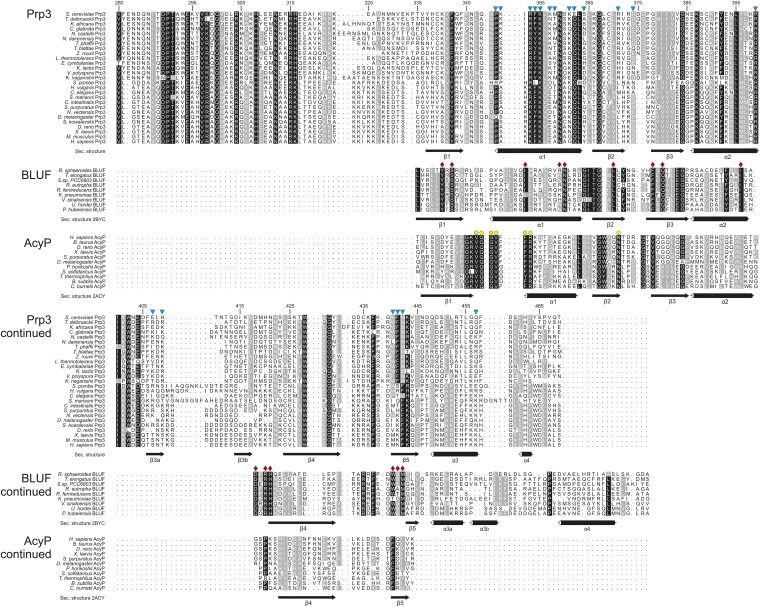
Protein sequence comparisons.Multiple sequence alignments of Prp3 orthologs, acylphosphatases (AcyP) and blue light photoreceptors containing the BLUF domain. Sequences were aligned using the program MUSCLE (Edgar, 2004), manually adjusted and displayed using ALSCRIPT (Barton, 1993). Symbols below the alignments denote secondary structure elements assigned using PDBsum (Laskowski et al., 1997) based on the crystal structures of yPrp3CTF (this study), Bos taurus AcyP (PDB ID 2ACY) (Thunnissen et al., 1997) and the R. sphaeroides BLUF domain (PDB ID 2BYC) (Jung et al., 2005). Cyan triangles—yPrp3296−469 residues in contact with yU6 snRNA; red diamonds—residues in the flavin-binding pocket of the R. sphaeroides BLUF domain, yellow circles—phosphate-binding and active site residues in B. taurus AcyP. Residue numbers refer to the yPrp3 sequence.